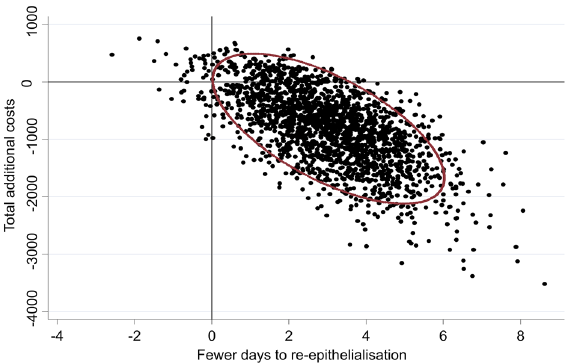
Figure 1. Incremental cost-effectiveness of adjunctive NPWT versus standard care with 95% confidence ellipse.